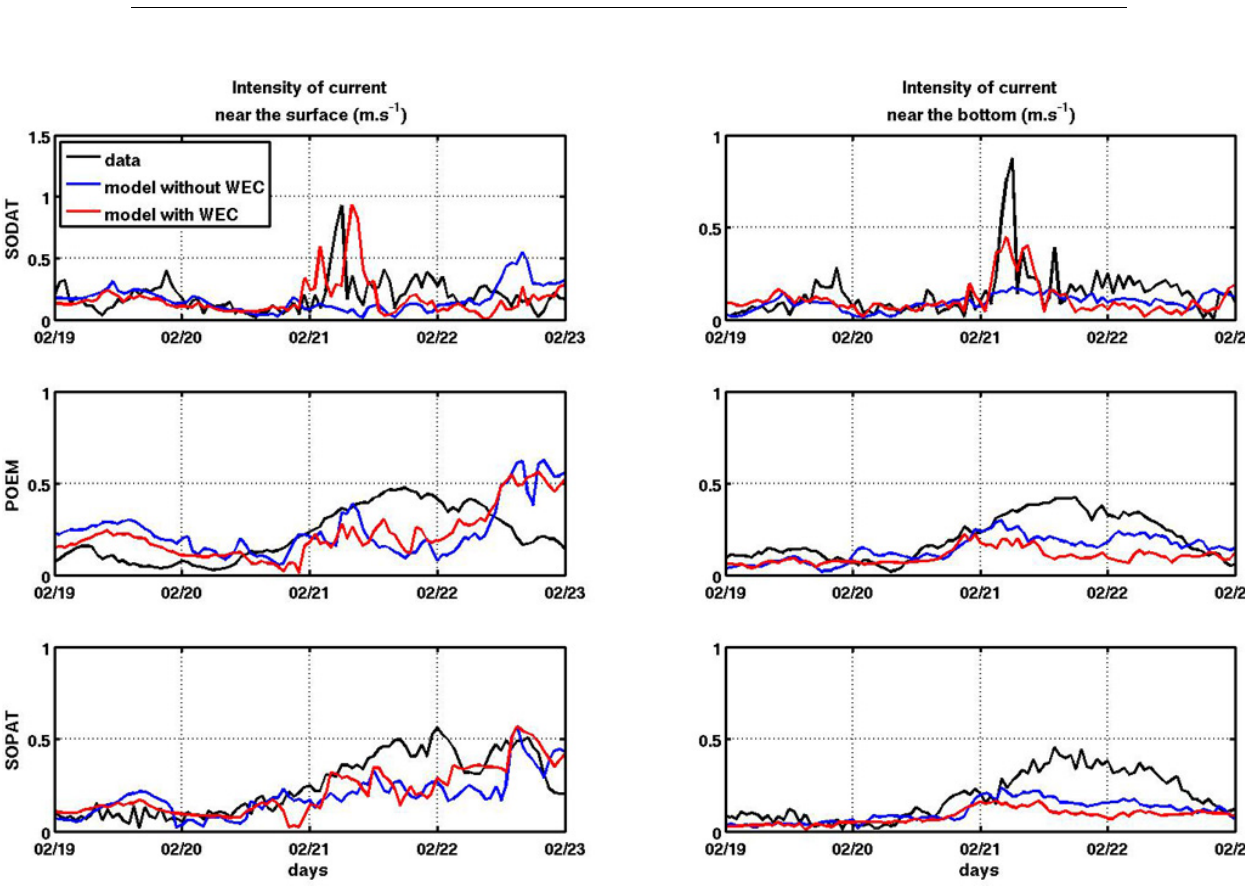
Fig. 12. Comparison of the current intensity near the bottom (right) and close to the surface (left) at the three instruments, between the measured current (black) and the simulated current with (with WEC – red) and without the wave forcing (without WEC –